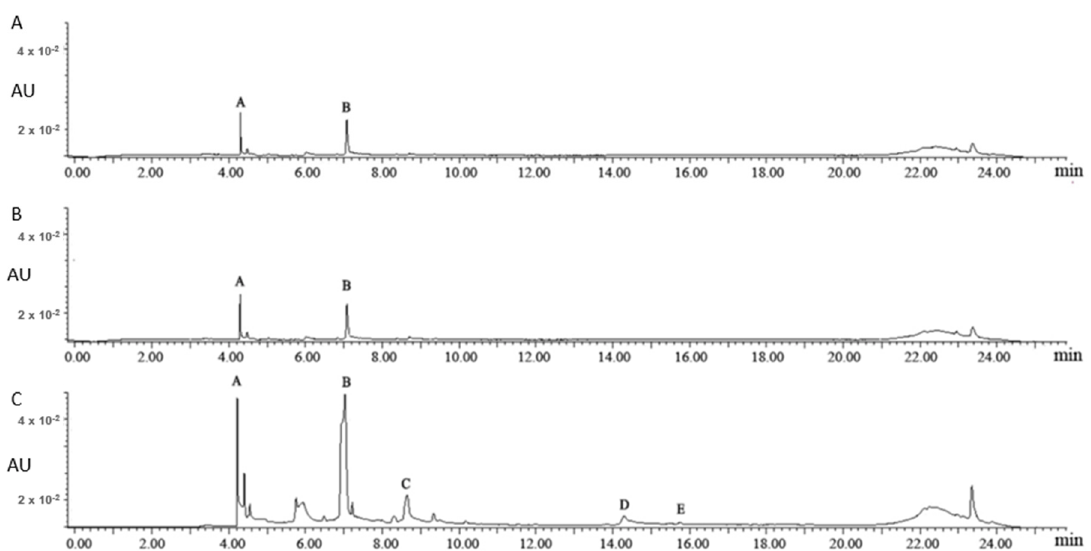
Figure 1. The ultra-high-performance liquid chromatography (UPLC) chromatograms of the aqueous fractions of different uploading volumes: 1 mL ( A ), 2.5 mL ( B ) and 5.0 mL ( C ). Note: Peak A: 3-galloylquinic acid; Peak B: caffeine; Peak C: ( − )-epigallocatechin gallate; Peak D: ( − )-epicatechin gallate; Peak E: kaempferol-3- O -glucosyl-rhamnosyl-glucoside. Peaks B, C, and D were identified by authentic standards; Peaks A and E were identified based on MS and references.